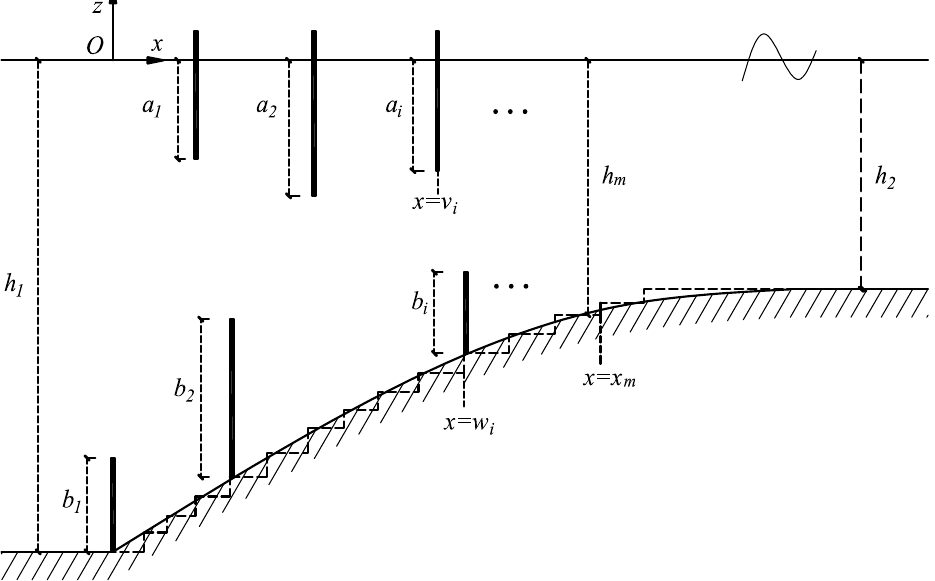
Figure 1. Definition of EMM for problems of water wave scattering by multiple thin barriers over undulation bottom.